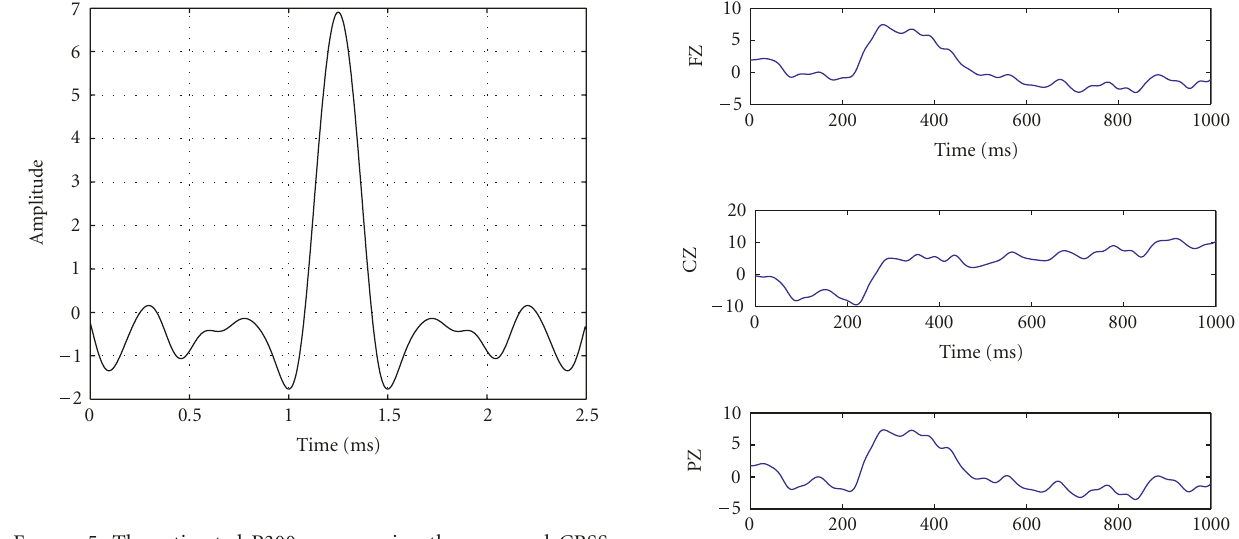
Figure 5: The estimated P300 source using the proposed CBSS. CBSS achieves a slightly better representation but with a decrease in mean square error than normal Infomax.